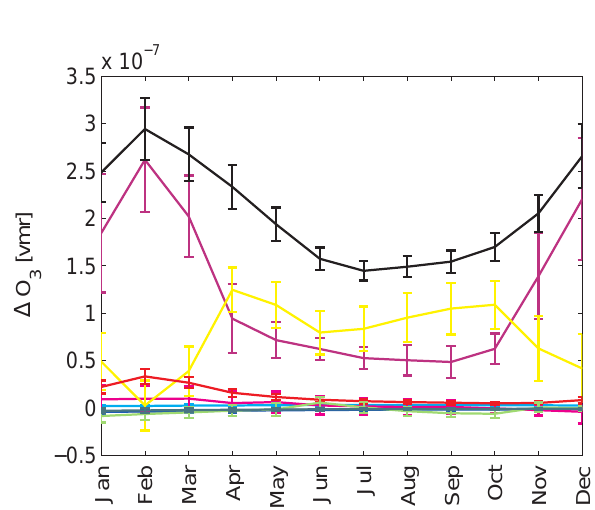
Fig. 6. As in Fig. 4, but difference 2040s minus 2000s. Colours follow Fig. 2: yellow: local, purple: tropical middle stratosphere, pink: tropical lower stratosphere. Here, the vertical bars denote the 1 σ uncertainty in the differences.